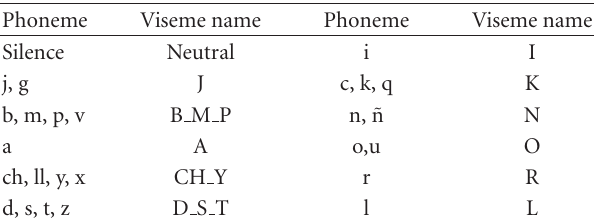
Table 2: Mexican-Spanish viseme definitions.